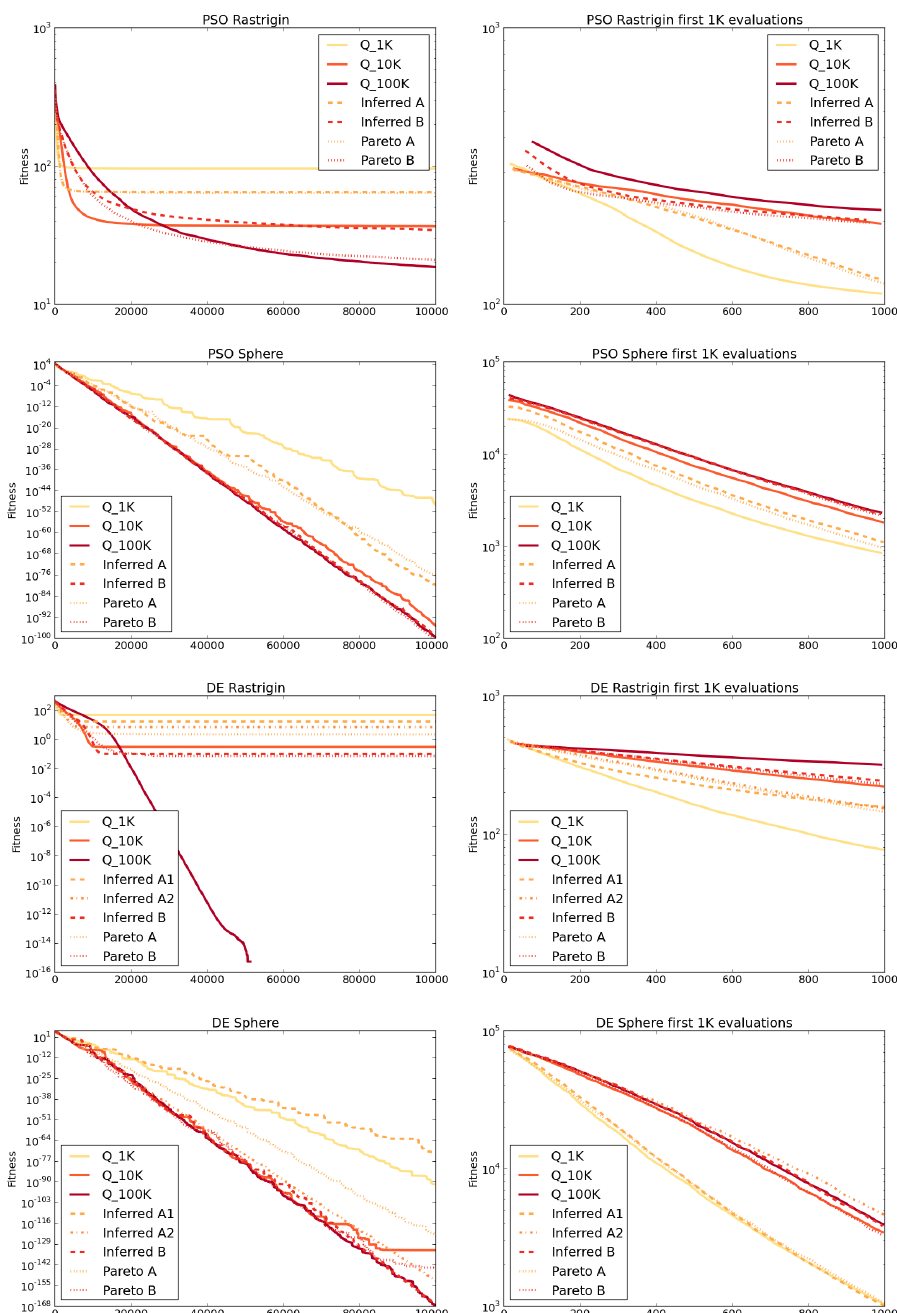
Figure 7. Average fitness versus number of fitness evaluations for configurations generated for PSO (first and second rows) and DE (third and fourth) for the 30-dimensional Rastrigin (above) and Sphere (below) functions. The plots on the right magnify the first 1000 evaluations to better compare the performance of the “fast”